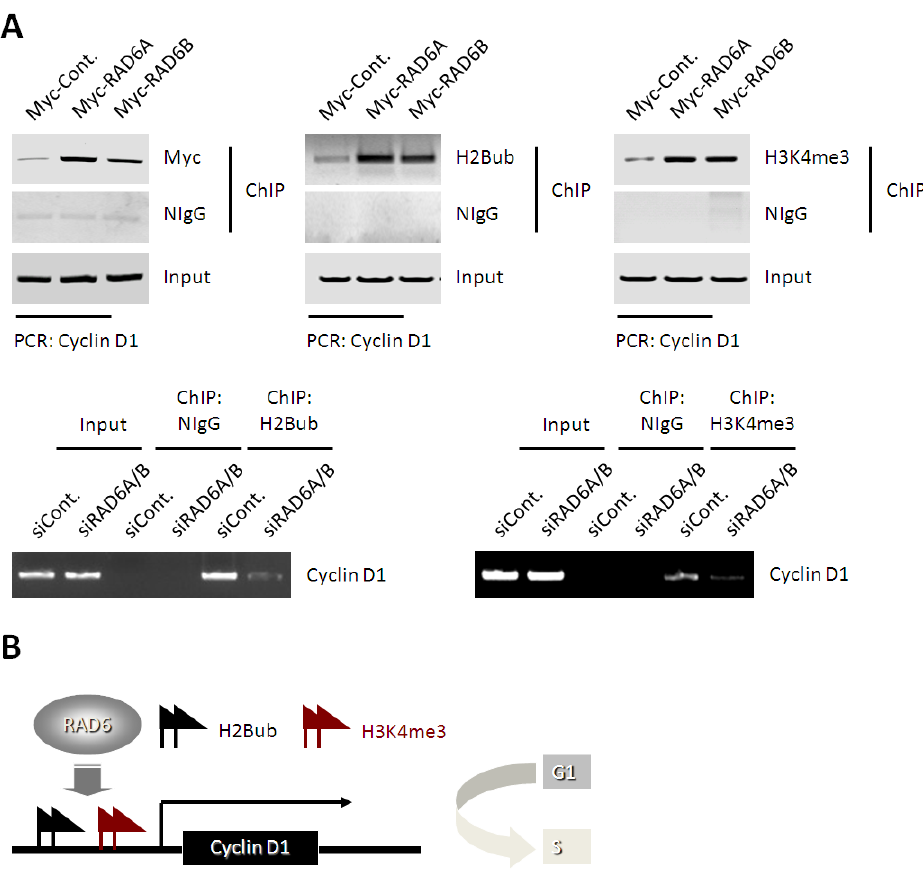
Figure 4. RAD6 enhances the enrichment of H2B monoubiquitination and H3K4me3 level at CCND1 promoter region. ( A ) HL-7702 cells transfected with an empty control or Myc-RAD6 expressing plasmids, or a control siRNA or RAD6 specific siRNAs were lysed and sonicated, then subjected to chromatin immunoprecipitation (ChIP) assays with antibodies against Myc-tag (indicating exogenous RAD6), H2B monoubiquitination and H3K4me3. Nonspecific antibody, normal rabbit IgG (NIgG), was used as a negative control. The precipitated DNA fragments were supplied for PCR assay with primers specific for CCND1 promoter. ( B ) Working model. RAD6 regulates the transcription of CCND1 likely through affecting the H2B monoubiquitination and H3K4me3 levels at the CCND1 promoter region. Figure S3 RAD6 overexpression does not affect the protein levels of cyclin A, cyclin E, cyclin B1 and Chk2. HL-7702 cells transfected with an empty control or Myc-RAD6 expressing plasmids were lysed and subjected to western blot assays with antibodies as indicated. (TIF)